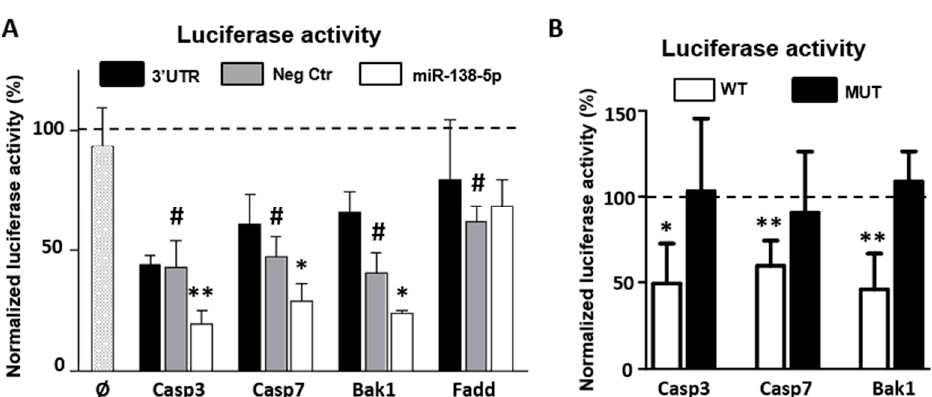
Figure 5. MiR-138-5p targets the 3 (cid:48) UTR of Casp3, Casp7, and Bak1: ( A ) Luciferase activity assays were carried out in C6 neural cell line cultures transfected with the complete 3 (cid:48) UTR of its three targets and co-transfected with mimics of miR-138-5p (white bars), negative control (Neg Ctr, gray bars), or without mimetics (black bars). Additional controls included C6 cultures transfected with a Luciferase construct without 3 (cid:48) UTR (Ø bar) or with Fadd 3 (cid:48) UTR. Values are expressed as the percentage of the luciferase activity of the empty construct (reference value represented as a dotted line in each experiment). Bars represent the mean ± SD of three independent experiments except for Casp3 ( n = 5). Luciferase activity of the different 3 (cid:48) UTR reporter constructs co-transfected with the negative control microRNA mimic (Neg Ctr) was compared to the empty construct through a paired t -test (# denotes a significant difference: p < 0.05). The effect of transfecting miR-138-5p mimic was compared to the effect of the negative control (Neg Ctr) using a paired t -test (* and ** denote significant differences: p < 0.05 p < 0.01, respectively). ( B ) Luciferase assays carried out in C6 cell line cultures transfected with the wild type (WT; white bars) or mutant (black bars) 3 (cid:48) UTR of Casp3, Casp7, and Bak1. The dotted line represents the luciferase activity of the same construct transfected with Neg Ctr (set to 100 in each experiment). Bars represent the mean ± SD of four independent experiments. Luciferase activity of the WT and mutant 3 (cid:48) UTRs constructs co-transfected with the miR-138-5p mimic was compared to the values obtained after transfection with Neg Ctr using a paired t -test (* and ** denote significant differences: p < 0.05 and p < 0.01,